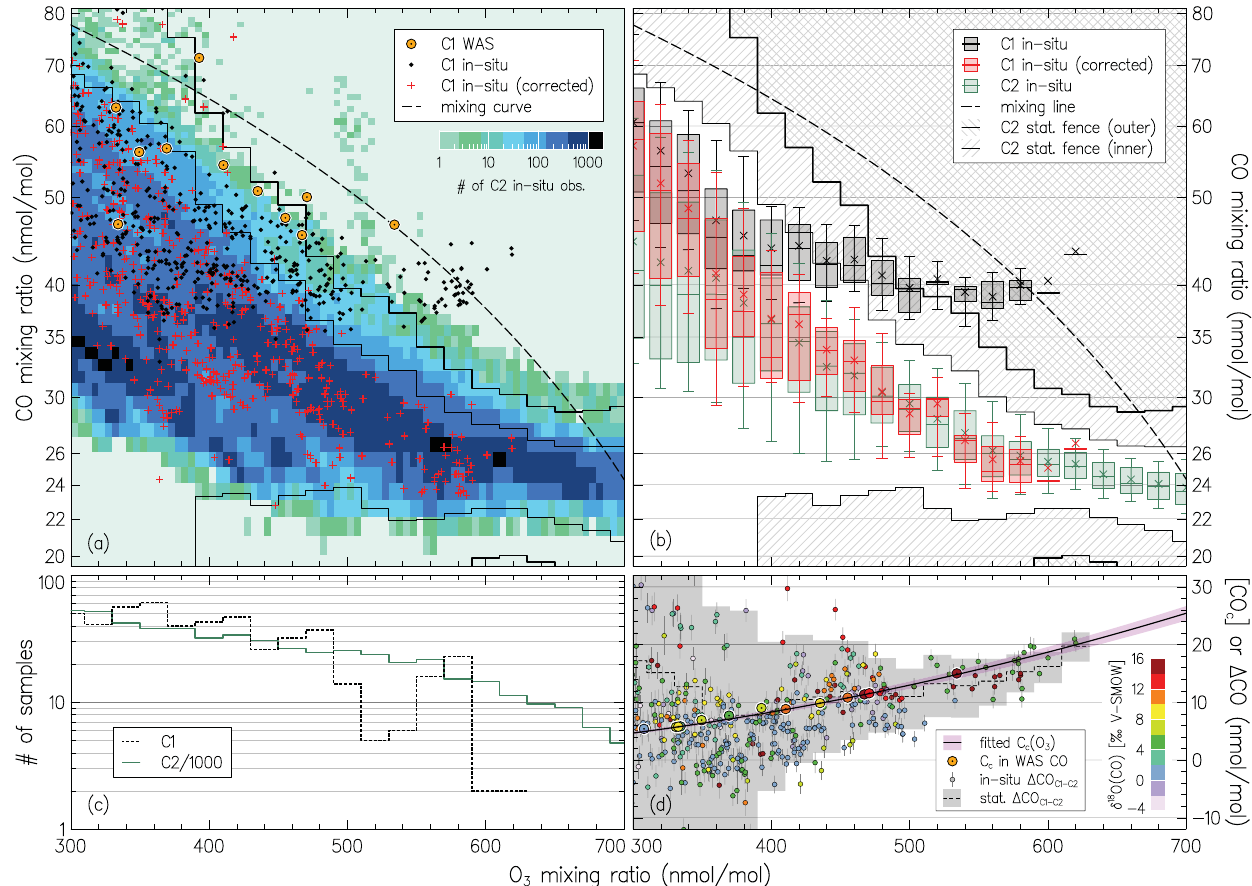
Figure 1. (a) Distribution of CO mixing ratios as a function of concomitant O 3 mixing ratios measured by CARIBIC in the LMS ([O 3 ]>300nmolmol − 1 ). The shaded area is the two-dimensional histogram of the C2 measurements (all C2 data obtained until June 2013) counted in 5 × 1nmolmol − 1 size [O 3 ] × [CO] bins, thus darker areas emphasise greater numbers of particular CO–O 3 pairs observed. Small symbols denote the original C1 in situ measurements (black) and corrected for the artefacts (red); the C1 WAS analyses (11 of total 408) are shown with large symbols. Thin and thick step lines demark the inner and outer statistical fences (ranges outside which the data points are considered mild or extreme outliers, see text) of the C2 data, respectively. The dashed curve exemplifies compositions expected from the linear mixing of very different (e.g. tropospheric and stratospheric) end members. (b) Statistics on CO mixing ratios from C1 and C2 data shown in box-and-whisker diagrams for samples clustered in 20nmolmol − 1 O 3 bins (whiskers represent 9th/91st percentiles). (c) Sample statistic for each CARIBIC data set (note the C2 figures scaled down by a factor of 1000). (d) Estimates of the C1 in situ CO contamination strength [CO c ] as a function of [O 3 ] (solid line) obtained by fitting the difference (cid:49) [CO] between the C2 and C1 in situ [CO] (small symbols) as detailed in Appendix A (Eq. A2). Step line shows the (cid:49) [CO] for the statistical averages (the shaded area equals the height of the inner statistical fences of the C2 data). Large symbols denote the estimates of [CO c ] in the C1 WAS data (slight variations vs. the in situ data are due to the sample mixing effects, see Sect. 3). Colour denotes the respective C1 WAS δ 18 O(CO) (note that typically 6–7 in situ measurements correspond to one WAS